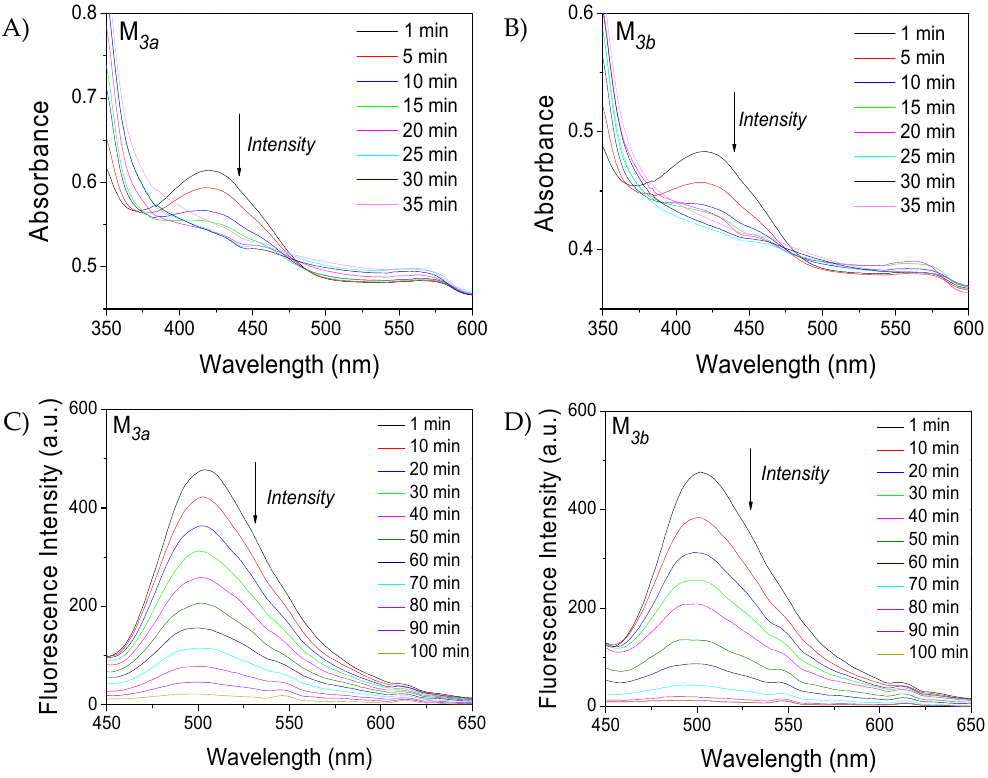
Figure 7. Absorption spectra for functionalized films M 3a ( A ) and M 3b ( B ) exposed to HCl vapors as a function of time (0–35 min). Fluorescence spectra for M 3a ( C ) and M 3b ( D ) after HCl vapors treatment (0–100 min).